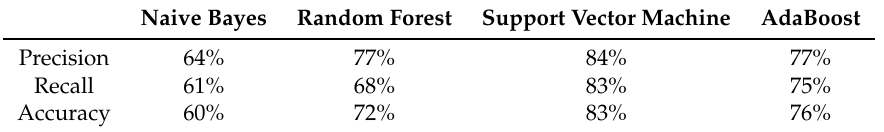
Table 5. The macro-precision and macro-recall for the 10-fold cross-validation is presented here. Naive Bayes Random Forest Support Vector Machine AdaBoost Precision